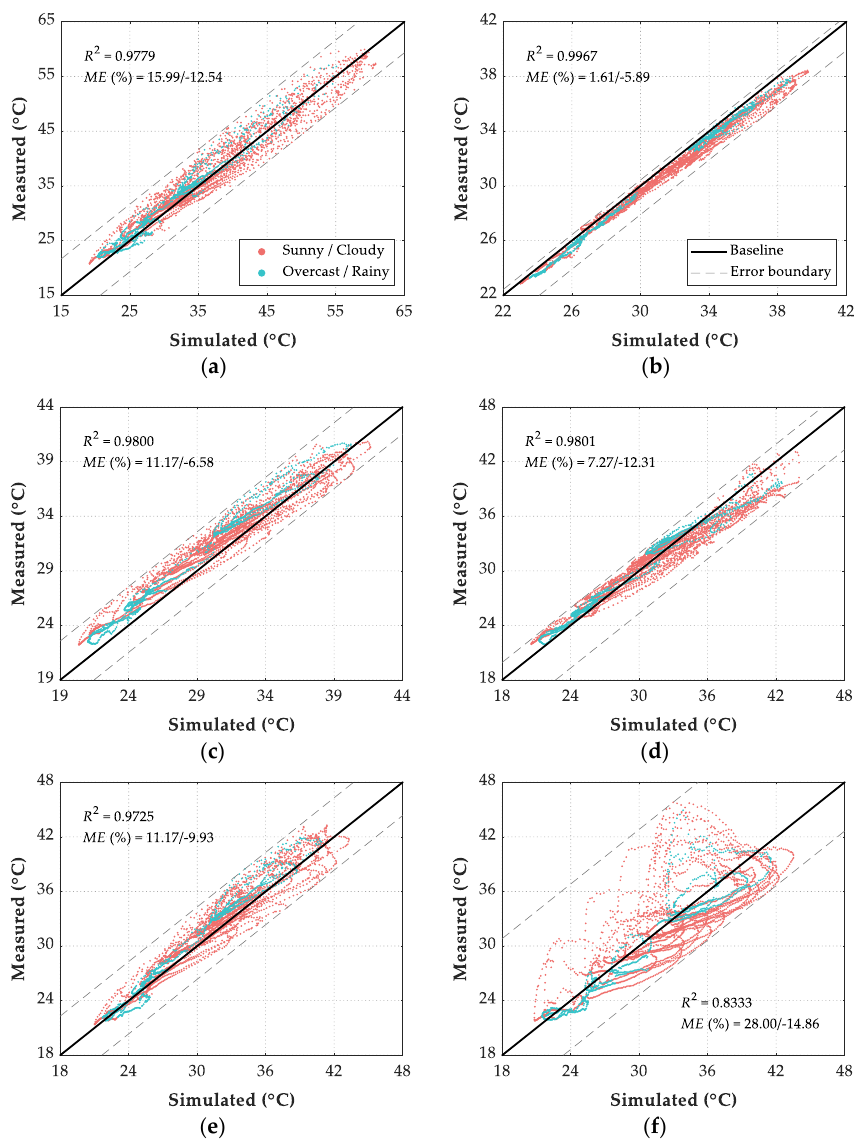
Figure 17. Comparison between FE simulated results and measured records of 6 points. ( a ) TS; ( b ) BS; ( c ) SS; ( d ) NS; ( e ) SP; ( f ) EP.